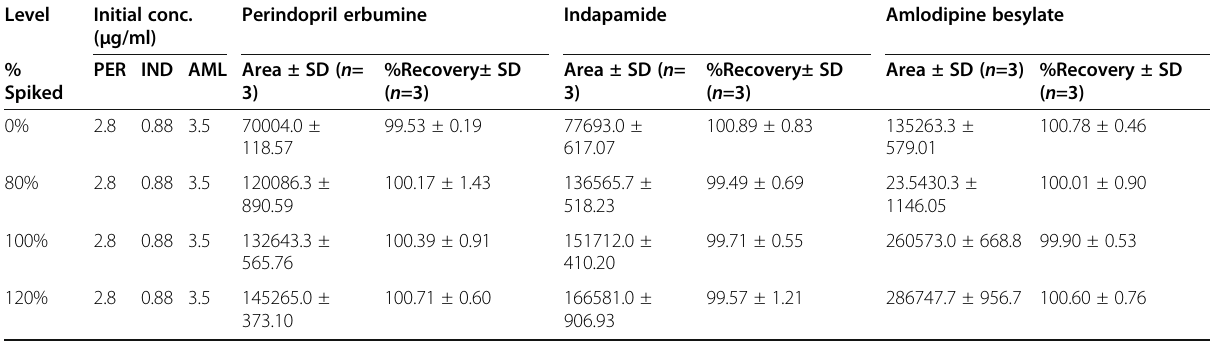
Table 2. Result of proposed accuracy study